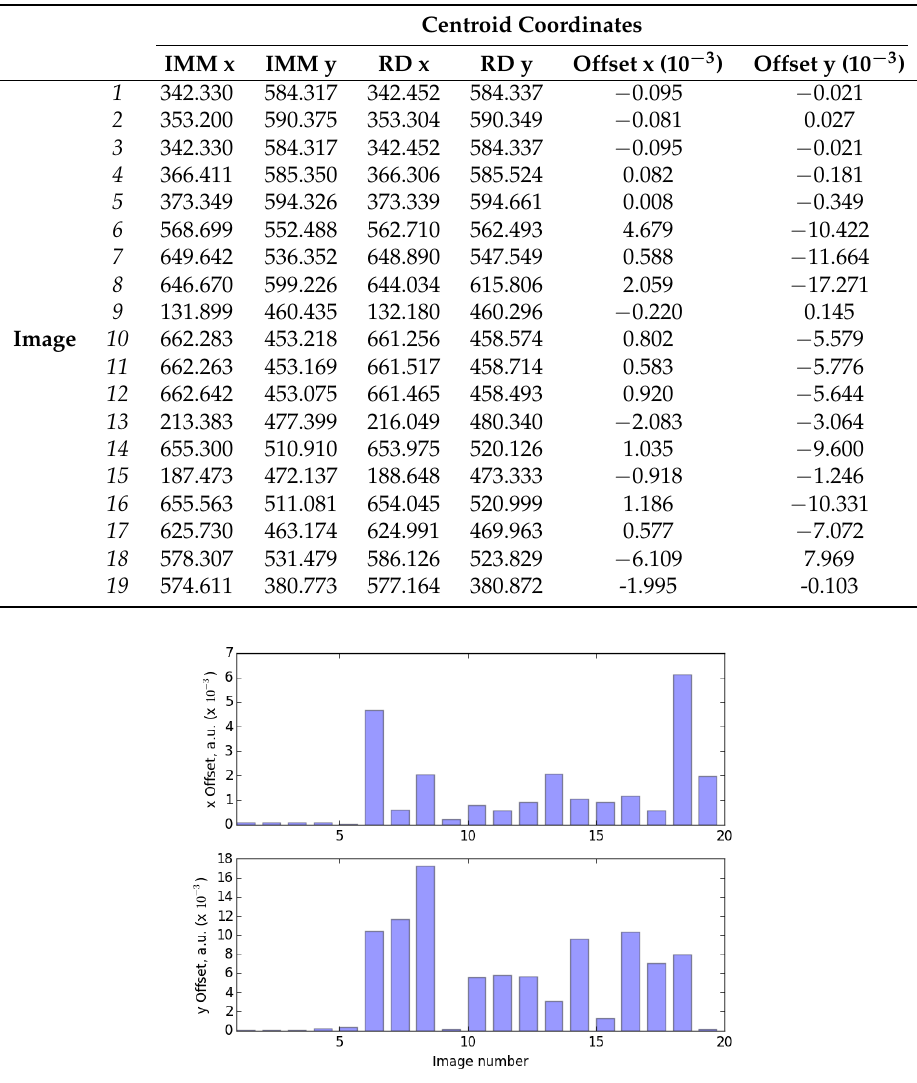
Table 2. The comparison between the image moment method (IMM) and the RD method. Coordinates are in pixels. The offset value is normalized to the number of pixels in each direction.